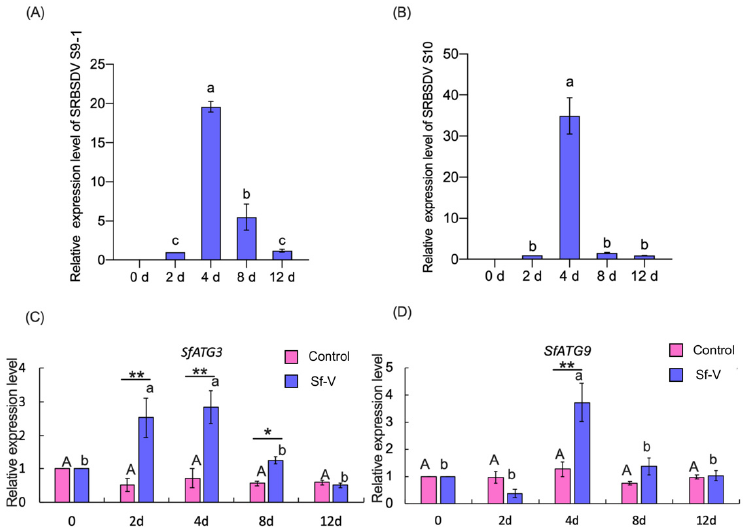
Figure 3. Temporal expression of SRBSDV S9-1 and S10 and autophagy-related genes in response to SRBSDV exposure. ( A ) SRBSDV S9-1. ( B ) SRBSDV S10. ( C ) SfATG3 . ( D ) SfATG9. The expression of SRBSDV S9-1 and S10 was undetectable at 0 dpe. Expression was normalized to the levels of SfEF1 α that serves as the internal standard. The relative mRNA levels of autophagy-related genes at 0 d and of SRBSDV S9-1 or S10 at 2 d were arbitrarily set to 1. Bars (mean ± S.E.) with different capital or lower-case letters indicate significant differences among times post-exposure (Tukey test, p < 0.05). Asterisk indicates significant difference between Sf-V and Control at a certain time post- exposure ( t -test, *, p < 0.05, **, p < 0.01). Sf-V: WBPH exposed to SRBSDV-infected rice plants; Con- trol: WBPH exposed to healthy rice plants. 3.3. SRBSDV Propagation and Transmission by WBPH Treated with dsRNAs When the WBPH females were fed with 400 ng/ μ L (mixed with 15% sucrose, v/v = 50:50) ds ATG3 for 24 h, the expression of SfATG3 was significantly suppressed in compar- ison with the insects fed with ds GFP (Figure 4A). A similar result was observed for the feeding of ds ATG9 (Figure 4B). Whereas, feeding WBPH females with 400 ng/ μ L ds ATG3 or ds ATG9 increased the expression of SRBSDV S9–1 and S10 significantly (S9-1, F = 6.080, df = 2,6, p = 0.036, Figure 4C; S10, F = 9.513, df = 2,6, p = 0.014, Figure 4D). Accordingly, SRBSDV acquisition rate (F = 130.8, df = 2,6, p < 0.001, Table 3) and inoculation rate (F = 14.81, df = 2,6, p = 0.005, Table 3) were improved significantly in WBPH females fed with 400 ng/ μ L ds ATG3 or ds ATG. Compared with ds GFP , ds ATG3 and ds ATG9 treatment improved the SRBSDV inoculation rate by 15.66% (Tukey test, p = 0.022) and 22.10% (Tukey test, p = 0.004), respectively; and increased SRBSDV acquisition rate by 31.43% (Tukey test, p < 0.001) and 35.91% (Tukey test, p < 0.001), respectively. The SRBSDV acqui- sition rate (Tukey test, p = 0.231) and inoculation rate (Tukey test, p = 0.339) showed no significant difference between ds ATG3 and ds ATG9 treatment.